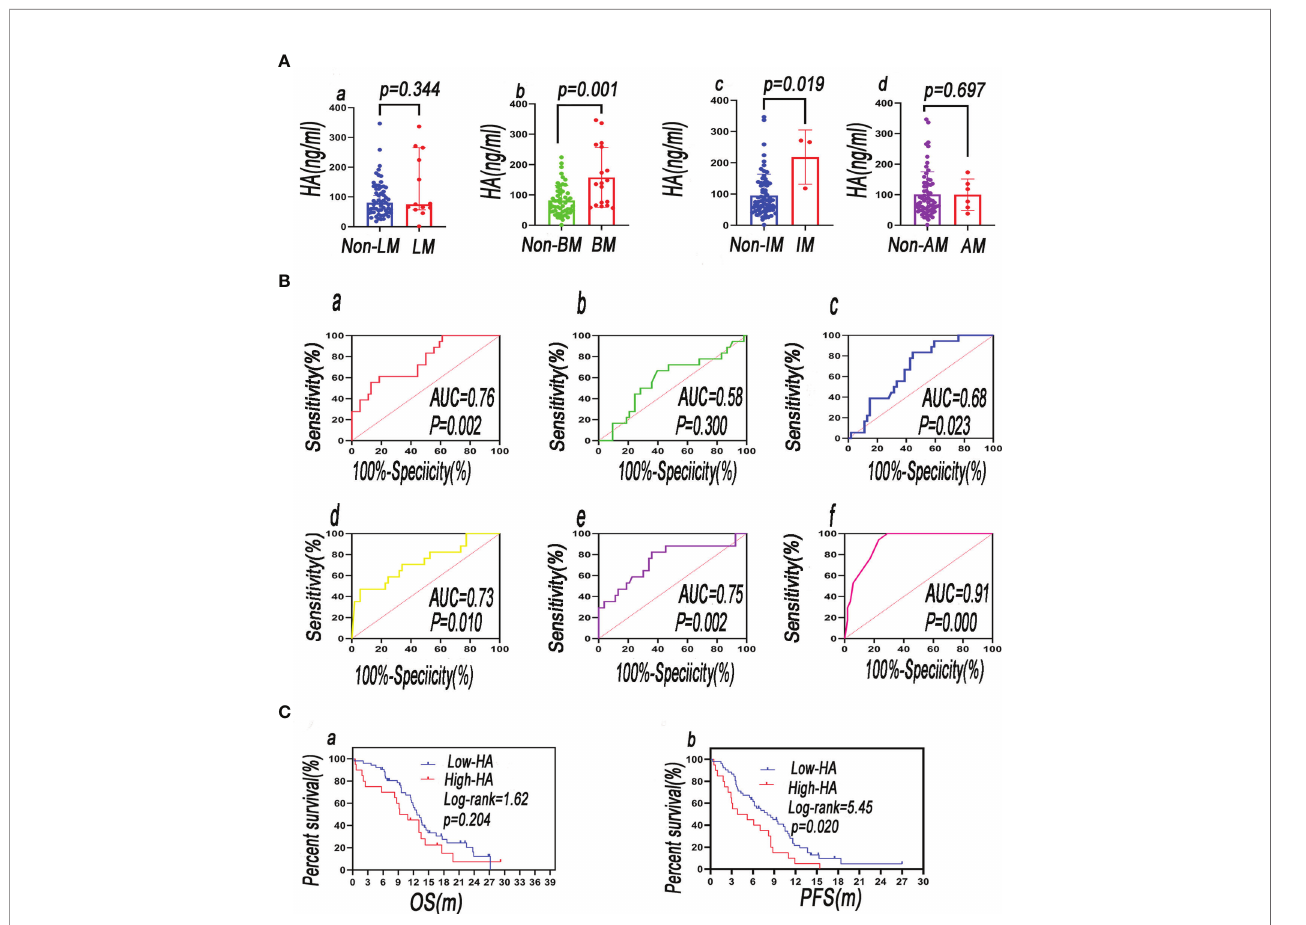
FIGURE 2 | The plasma level of HA in distant metastasis patients vs. that in non-distant metastasis patients — (Aa) LM, liver metastasis; (Ab) BM, bone metastasis; (Ac) IM, intracranial metastasis; (Ad) AM, adrenal metastasis. (B) ROC curves of blood biomarkers of patients were plotted to analyze their predictive value in BM [ (Ba) HA; (Bb) LDH; (Bc) OPN; (Bd) pro-GRP; (Be) CYFRA21-1; (Bf) combination of predictors]. (C) Comparing the survival rate between baseline HA low and baseline HA high groups ( a = OS; b =